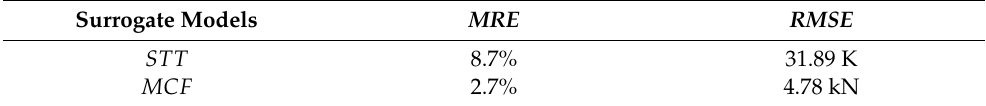
Table 4. Error analysis of surrogate models.